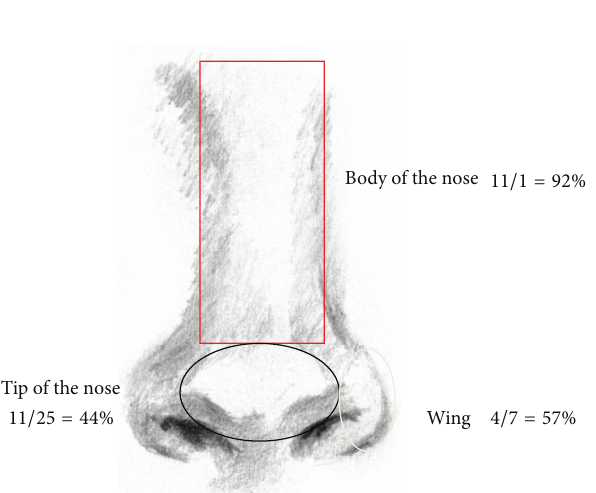
Figure 2: Location and response of the BCC in the nose.